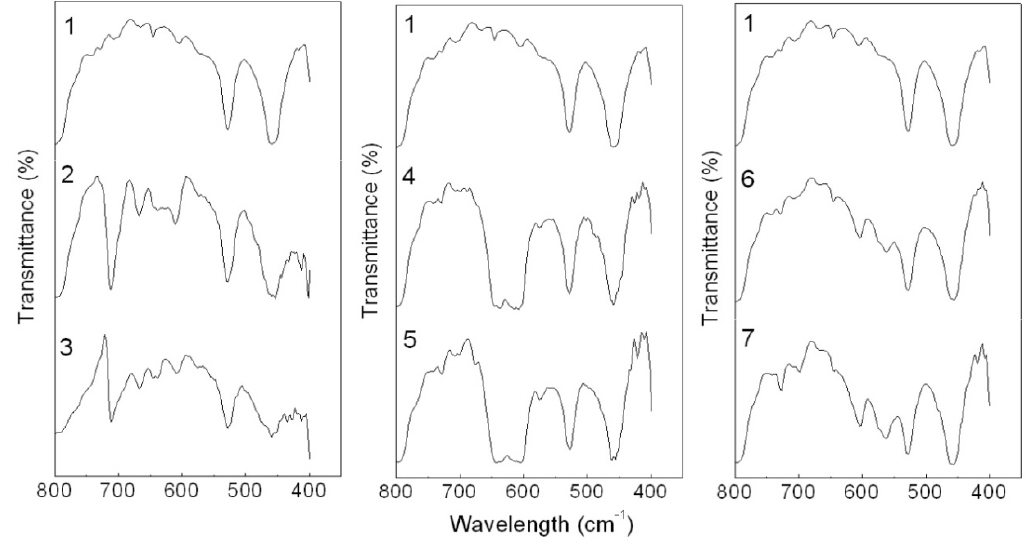
/APRB mixture (3), the BaSO 3 (PO ) -ABB6B hybrid (6) and the Ca 3 4 2